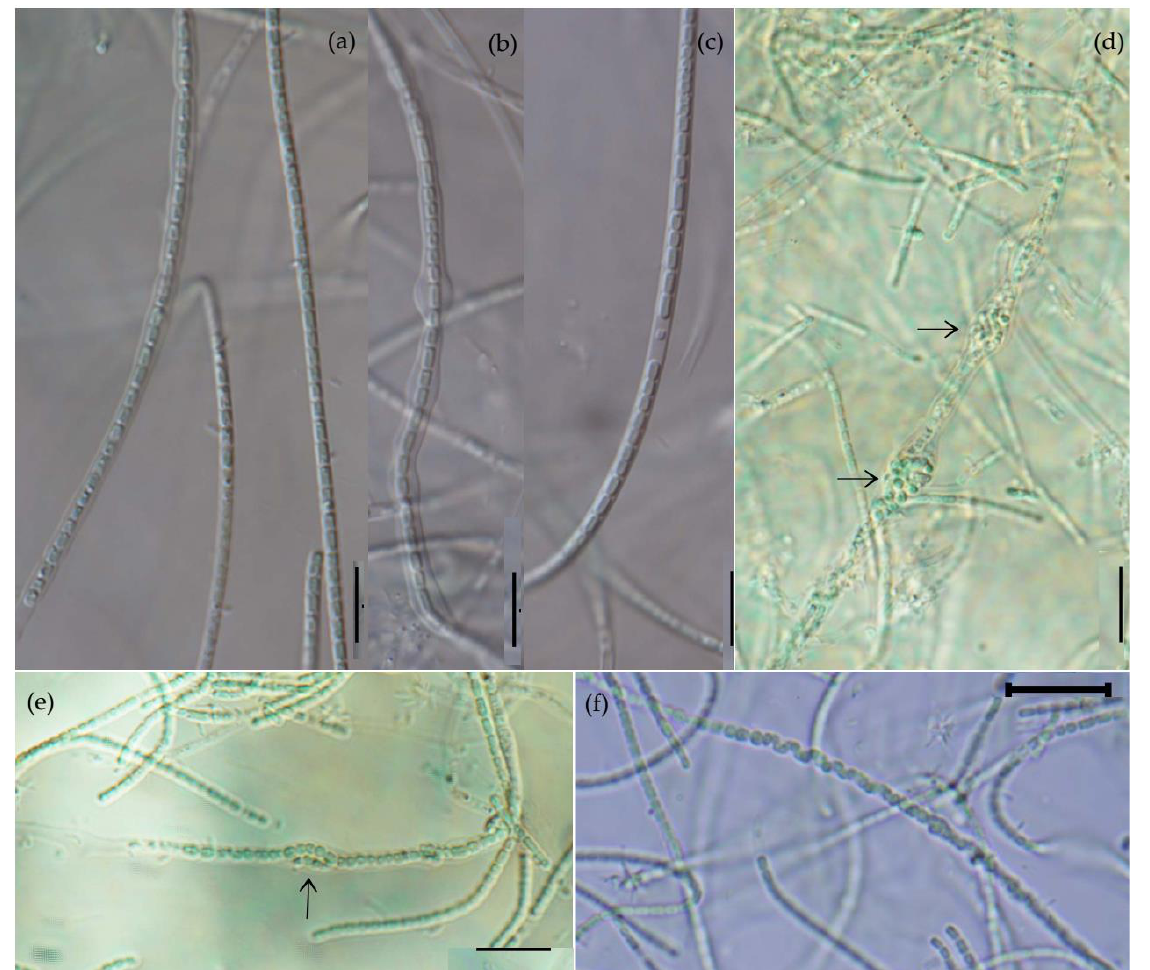
Figure 1. Light microscopy of Nodosilinea hunanesis strains. ( a – c ) A single trichome with a sheath.